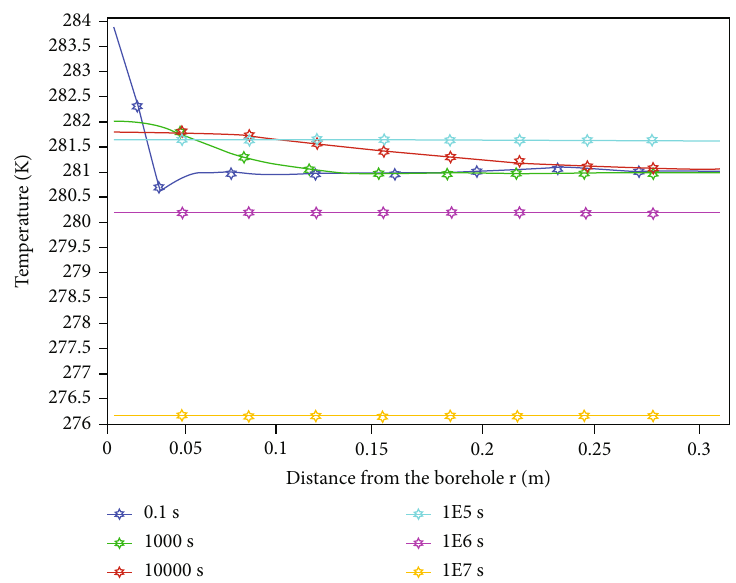
Figure 7: Temperature in the homogeneous coal rock during CBM